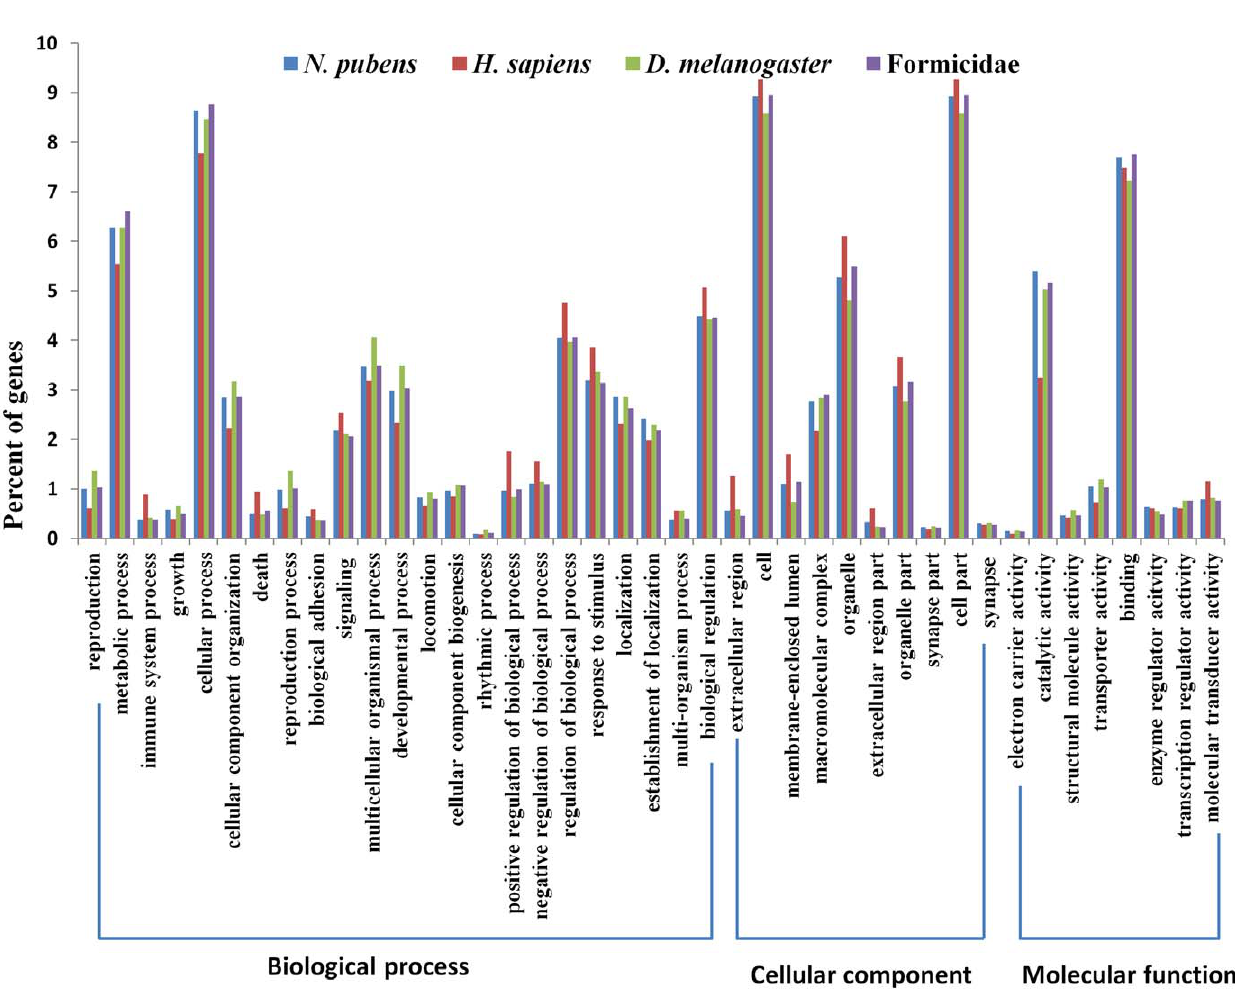
Figure 4. N.pubens sequences annotated with a gene ontology term (GO) and compared with reference sequences of Homosapiens , Drosophilamelanogaster , and Formicidae.